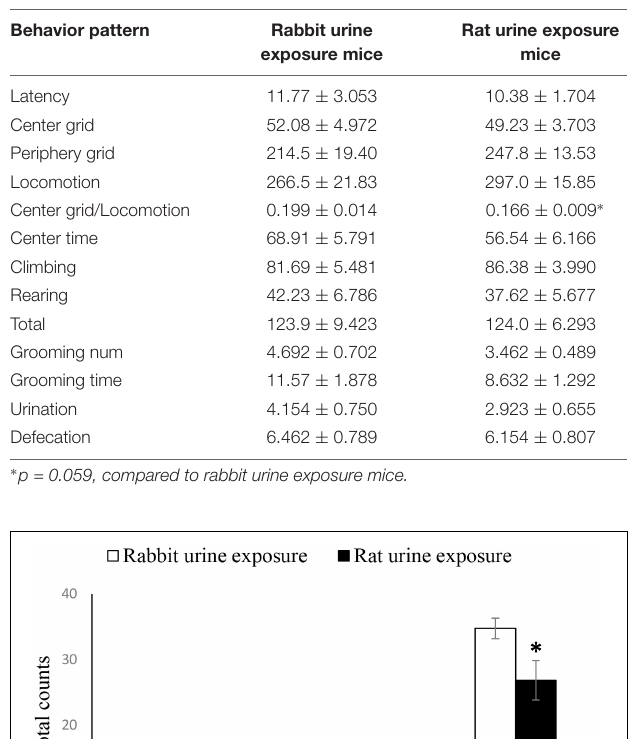
TABLE 1 | Effects of predator odor exposure on behaviors in open field test.